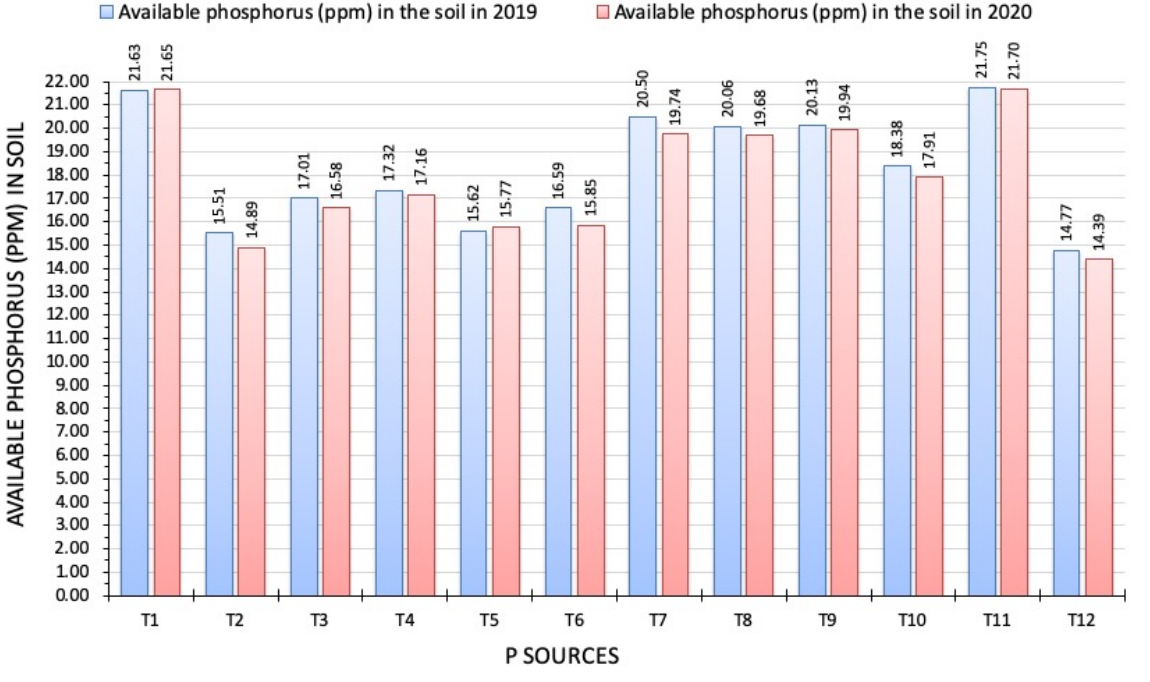
Figure 4. Available phosphorus in the soil at harvest was affected by arbuscular mycorrhizal fungi, phosphate-solubilizing bacteria and selected chemical phosphorus fertilizers in Sakha 106 rice cultivar in the 2019 and 2020 seasons. SSP, single super phosphate (15% P 2 O 5 ); PSBs, phosphate-solubilizing bacteria; AMFs, arbuscular mycorrhizal fungi; PNPs, phosphorus nanoparticles; PA, phosphoric acid. T1, basal application of 100% single super phosphate (SSP) (P 1 ); T2, basal application of